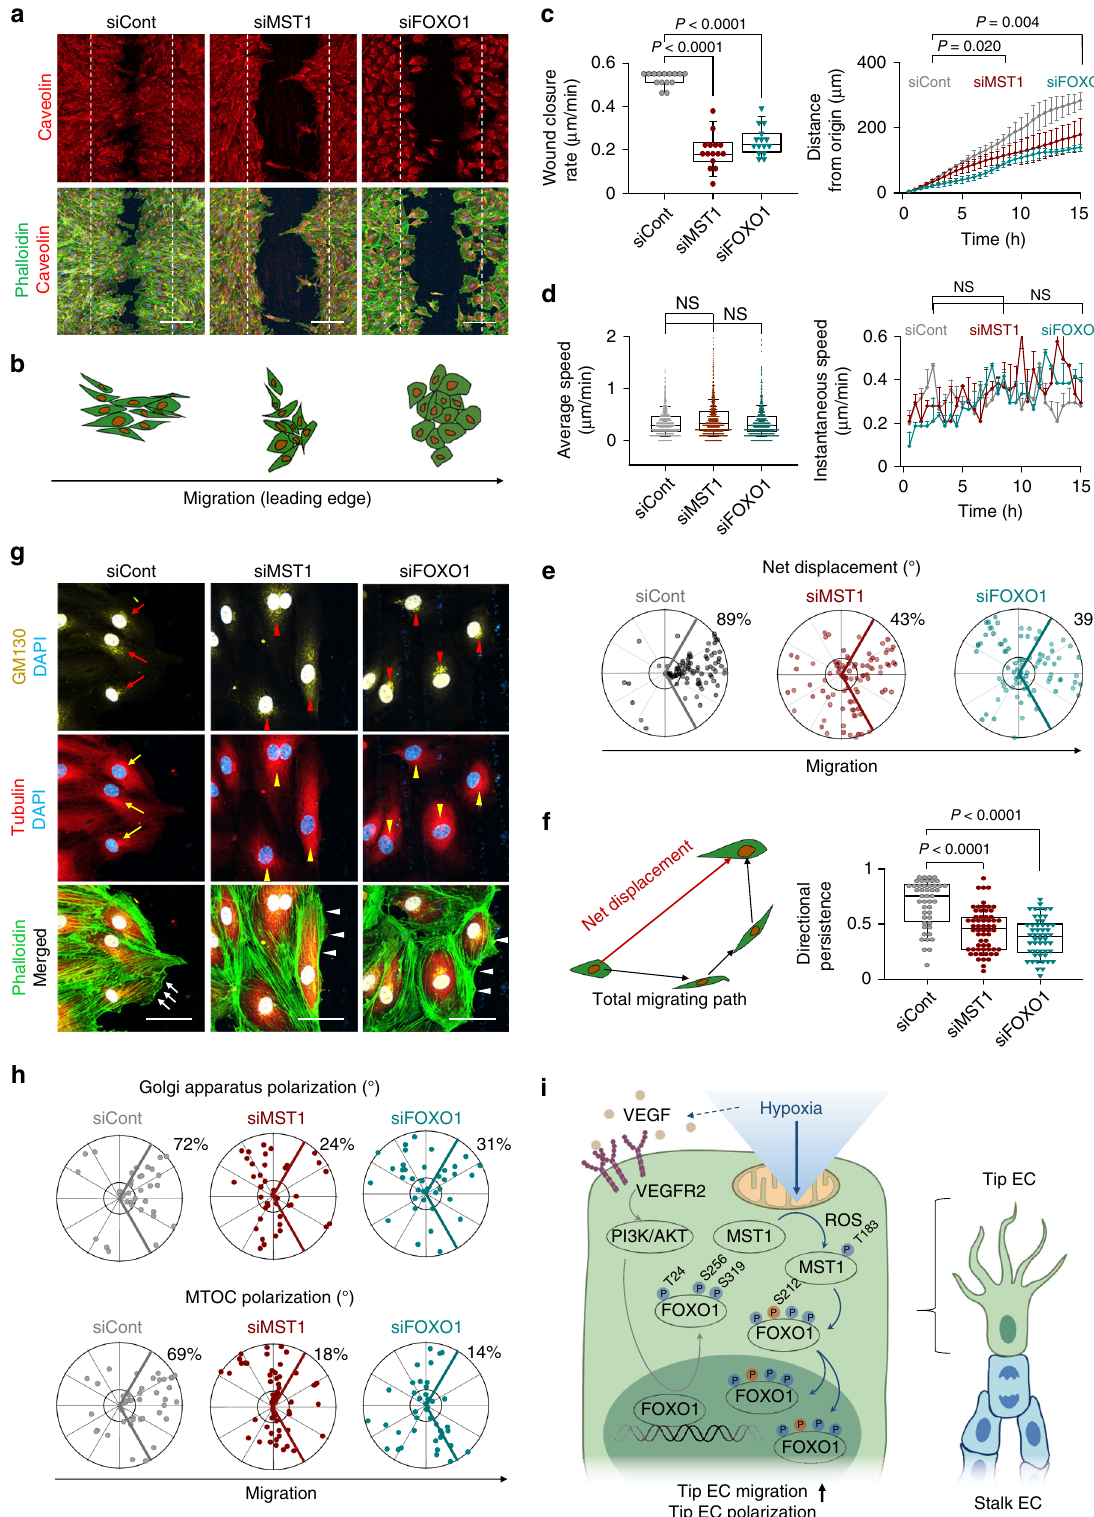
reagent used for IF were as follows: hamster anti-CD31 monoclonal (Millipore, MAB1398Z); isolectin B4 (IB4), Alexa Fluor 594-conjugated (Thermo Fisher Sci- enti fi c, I21413); rat anti-VE-cadherin monoclonal (BD Pharmingen, 555289); mouse anti-VE-cadherin monoclonal (BD Biosciences, #555661); rabbit anti-ERG monoclonal (Abcam, ab92513); rabbit anti-cleaved-caspase-3 (Cl-CASP3) poly- clonal (CST, #9664); rabbit anti-pHH3 polyclonal (Millipore, 05-806); rabbit anti- collagen IV polyclonal (Bio-Rad, 2150-1470); rat anti-ICAM2 monoclonal